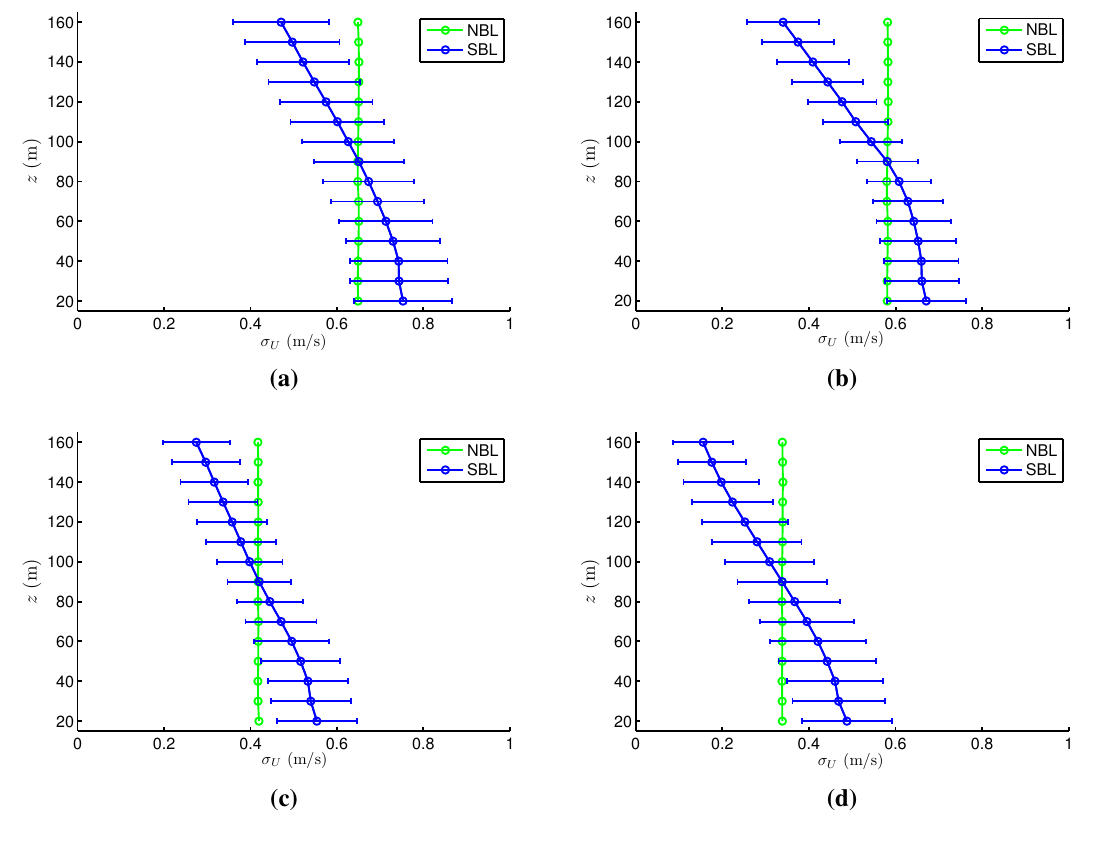
Figure 4. Comparison of turbulence standard deviation vertical profiles. ( a ) z